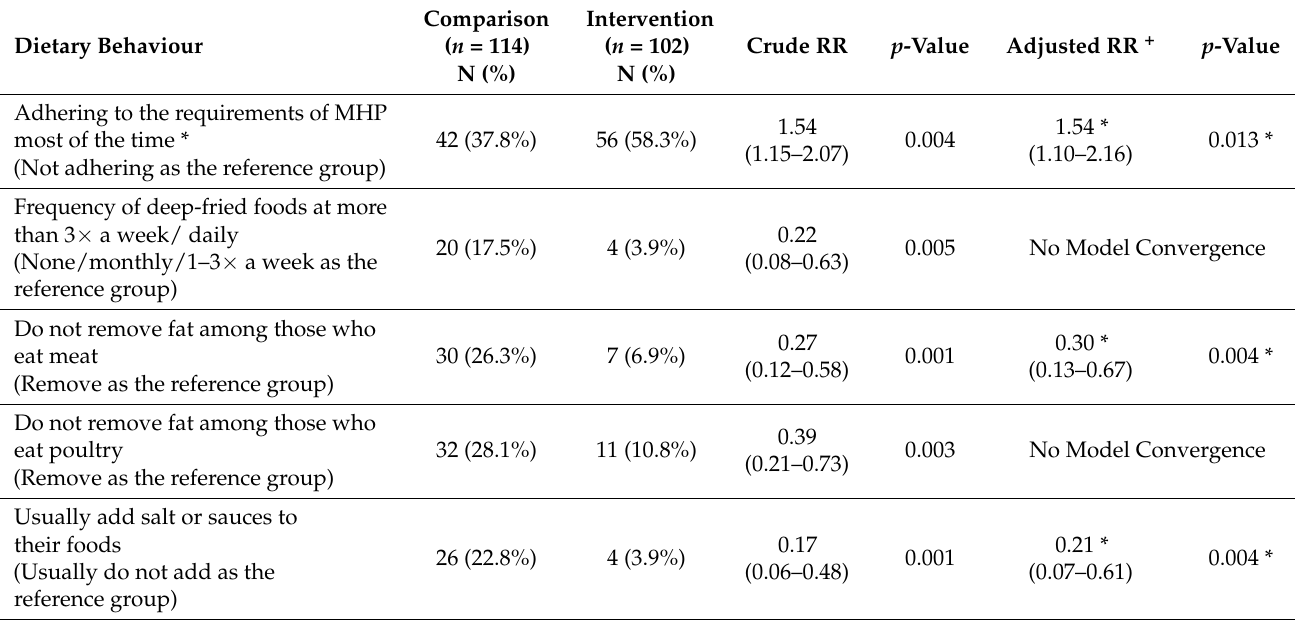
Table 3. Crude and adjusted risk ratio of dietary behaviours of the intervention and comparison groups at 1-year